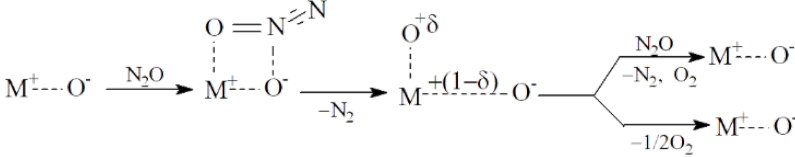
Scheme 1. Mechanism of N 2 O decomposition on Lewis acid-base pair sites. Table 1. N 2 O decomposition (45 cm 3 N 2 O/min).